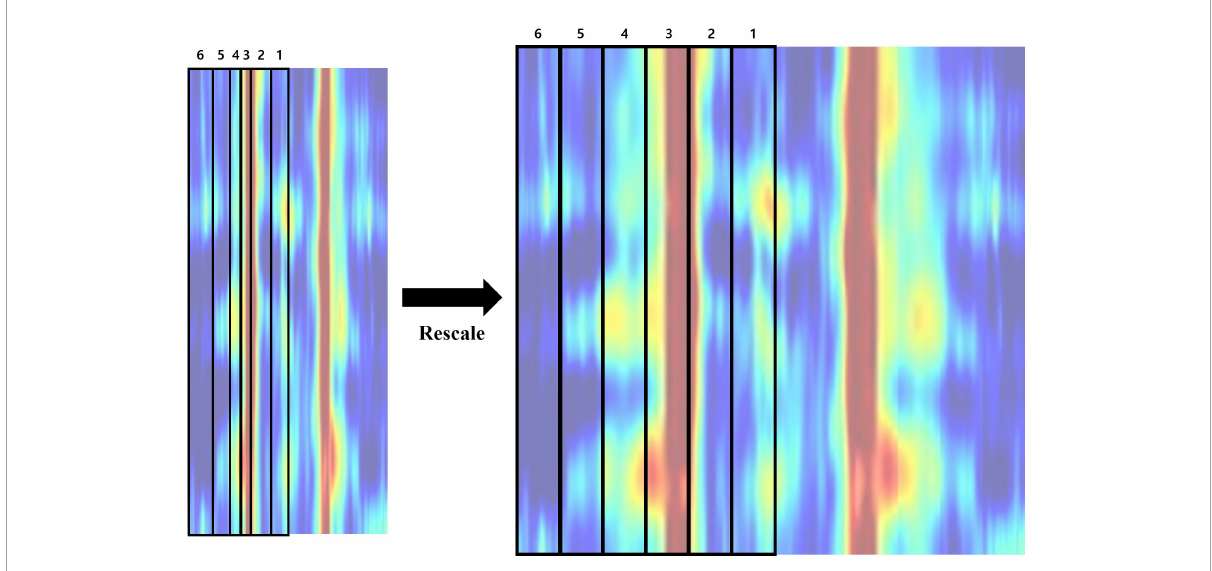
FIGURE5 Rescaling the proportions of frequency bands composing the feature image.